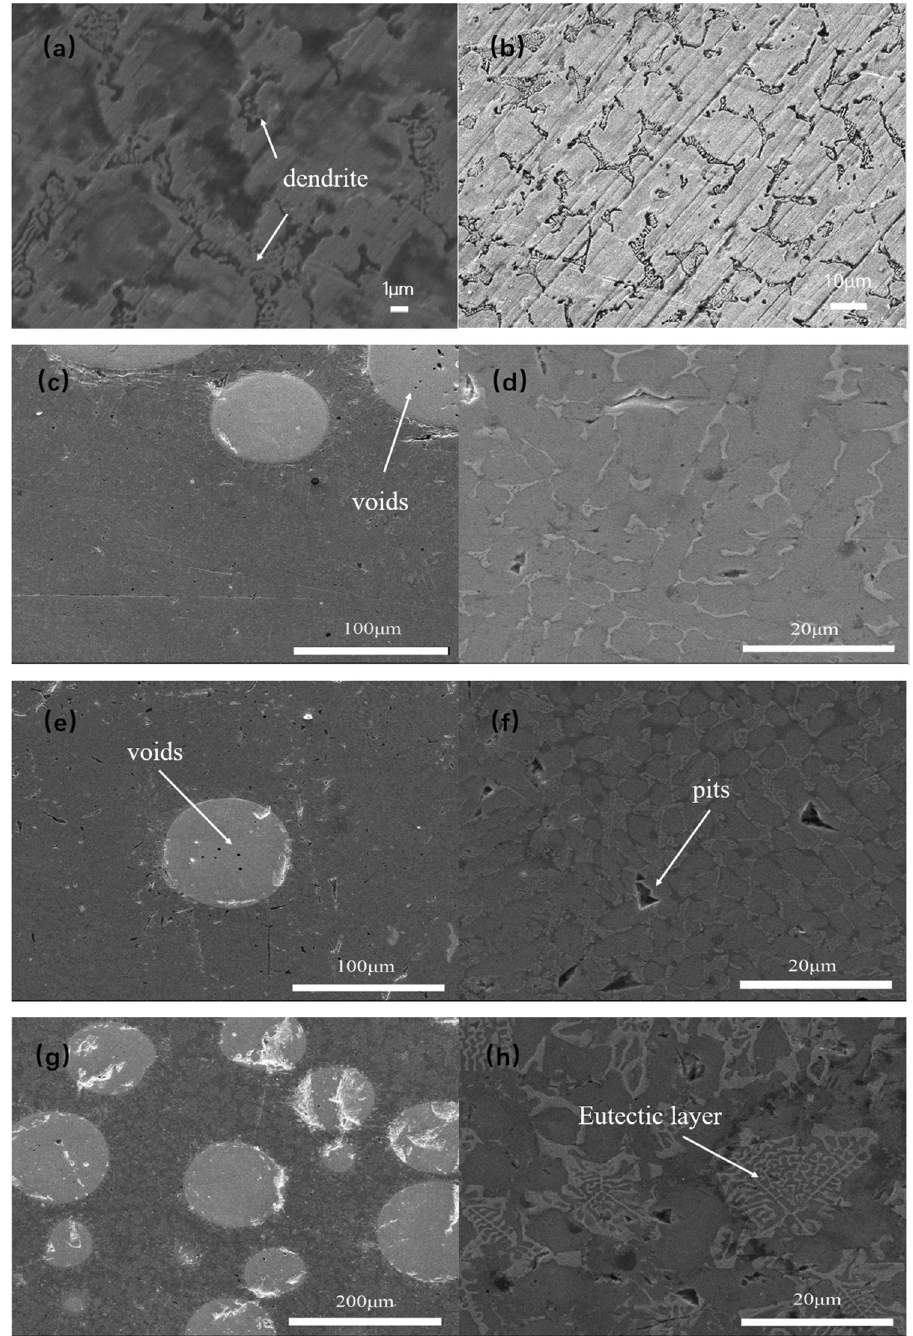
Figure 7: Microstructure of the Co - based PTA coating. ( a and b ) Co; ( c and d ) Co + 15% WC; ( e and f ) Co + 45% WC; ( g and h ) Co + 60%